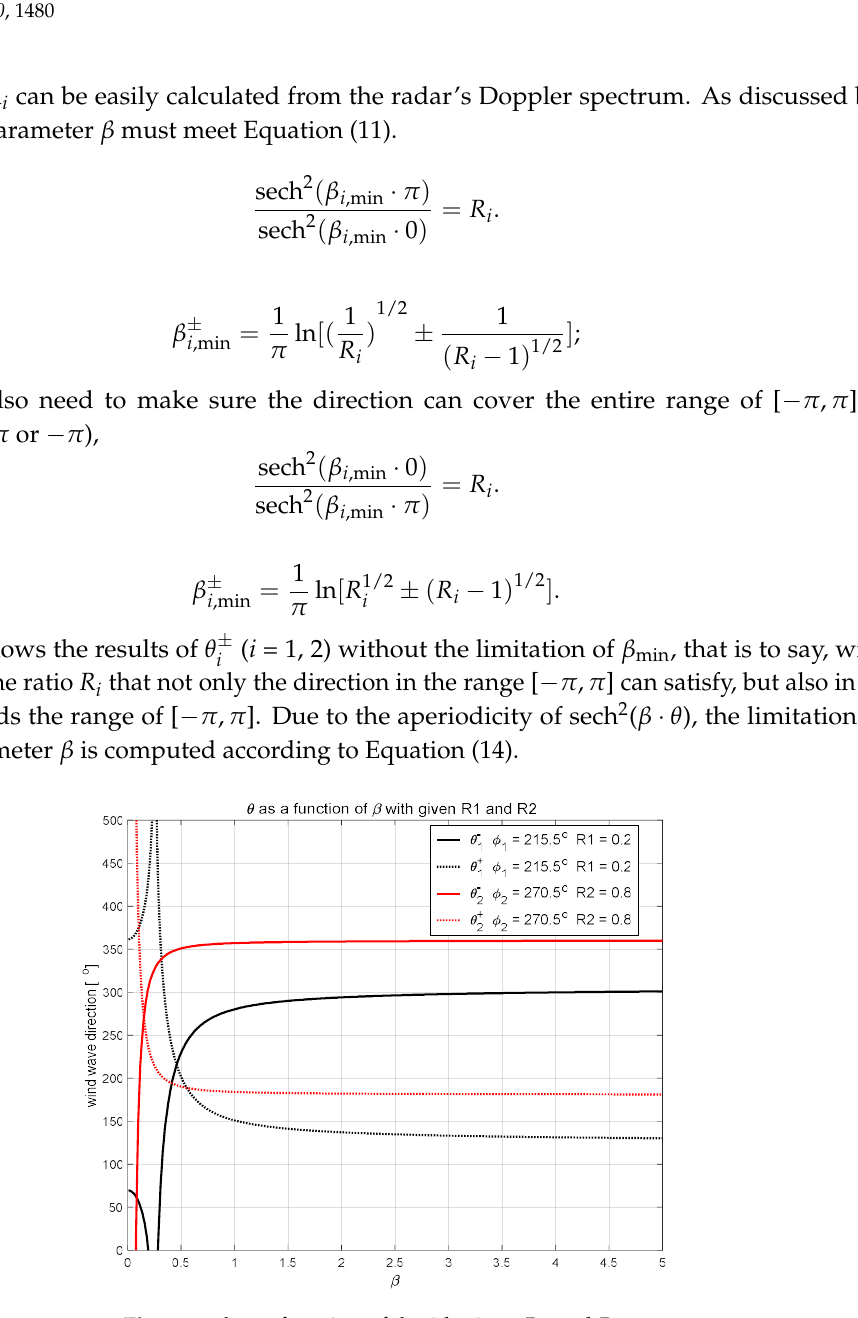
Figure 2. 𝜃 as a function of 𝛽 with given R 1 and R 2 . Figure 2. θ as a function of β with given R 1 and R 2